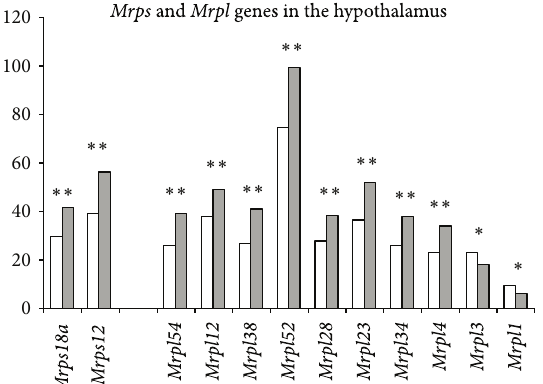
Figure 3: Differentially expressed mitochondrial ribosomal Mrps and Mrpl genes in the hypothalamus of mice following CSDS. The Cufflinks program was used to estimate the gene expression levels in FPKM. The levels of the Mrps and Mrpl gene expression are presented in the control (left columns) and depressive mice (right columns). The Mrpl54, Mrpl12, Mrpl38, Mrpl52, Mrpl28, Mrpl23, Mrpl34, Mrpl4, Mrps18a, Mrps12, Mrps18a, and Mrps12 genes were upregulated, whereas Mrpl1 and Mrpl3 were downregulated. Statis- tical significance 𝑃 < 0.01 and 𝑞 < 0.05 . ∗ 𝑃 < 0.01 ; ∗∗ 𝑃 < 0.001